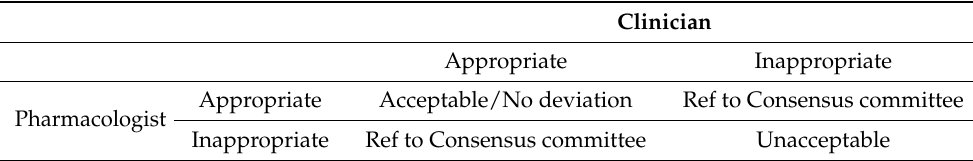
Table 1. Assessment framework for deviation of prescription through Rational Use of Medicine Consensus